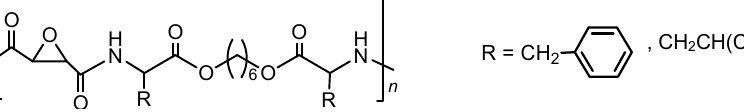
Figure 32. AABBP composed of epoxy-succinic